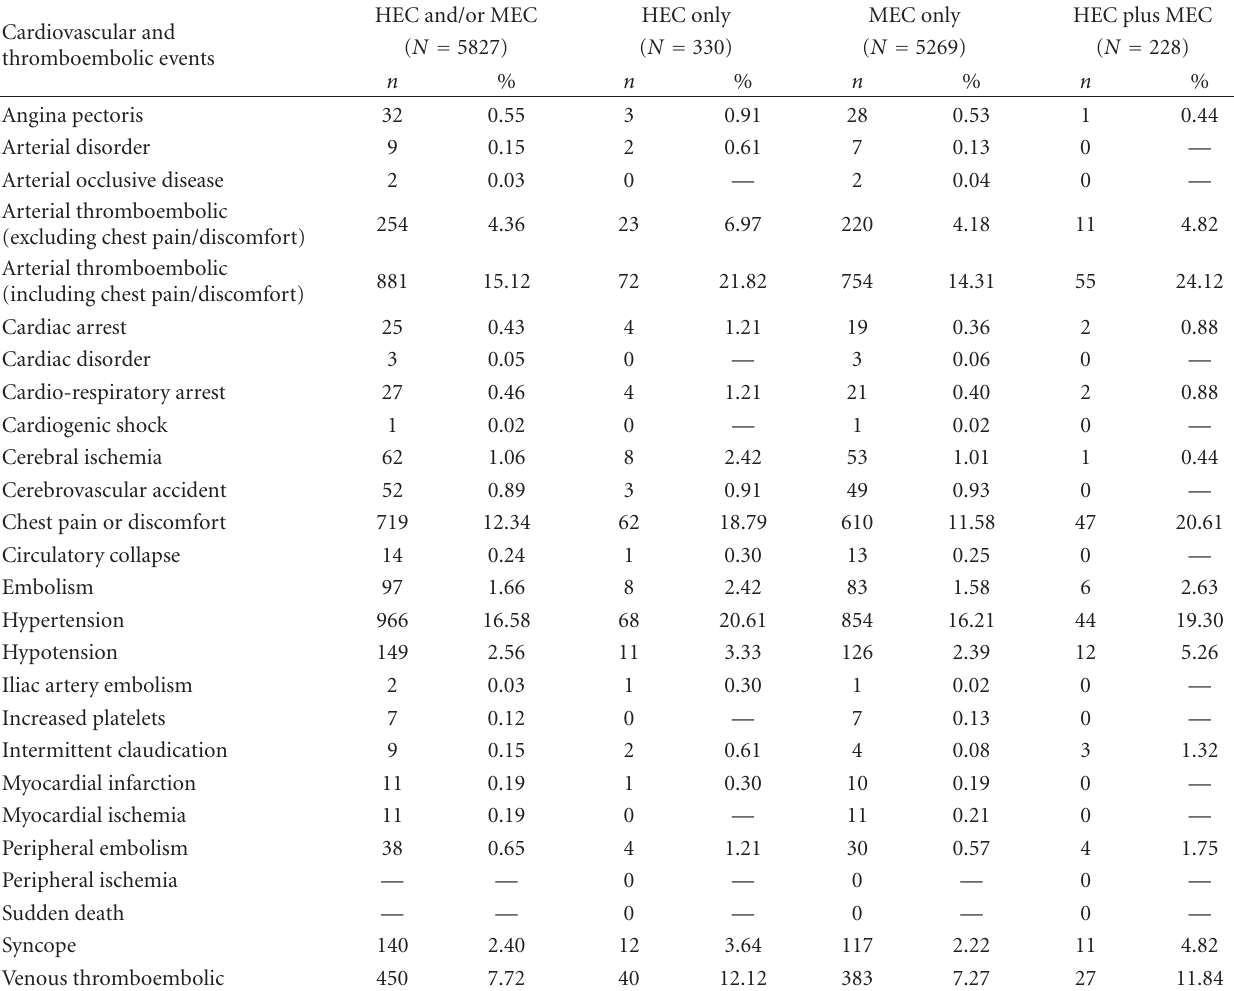
Table 2: Cardiovascular-related events in 5827 patients with select ∗ cancers and ≤ 4 cycles of HEC, MEC, or HEC/MEC combined, 2005– 2007 IMPACT National Benchmark Database (OptumInsight, Eden Prairie,